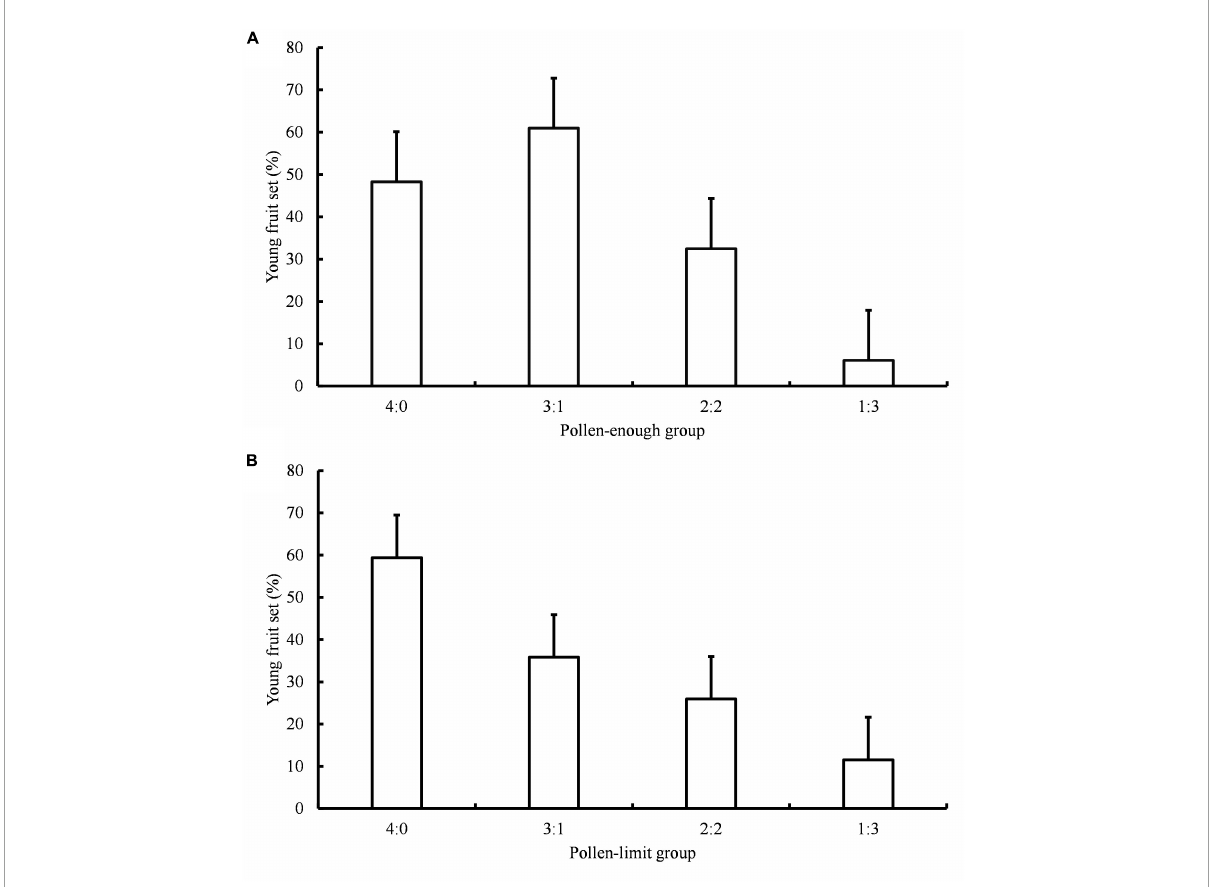
FIGURE1 Young fruit set under different hand-pollination treatment. (A) Young fruit set of pollen-enough group; (B) Young fruit set of pollen-limit group; C/S: ratio of cross- and self-pollen. Data are presented as mean ± Standard Deviation